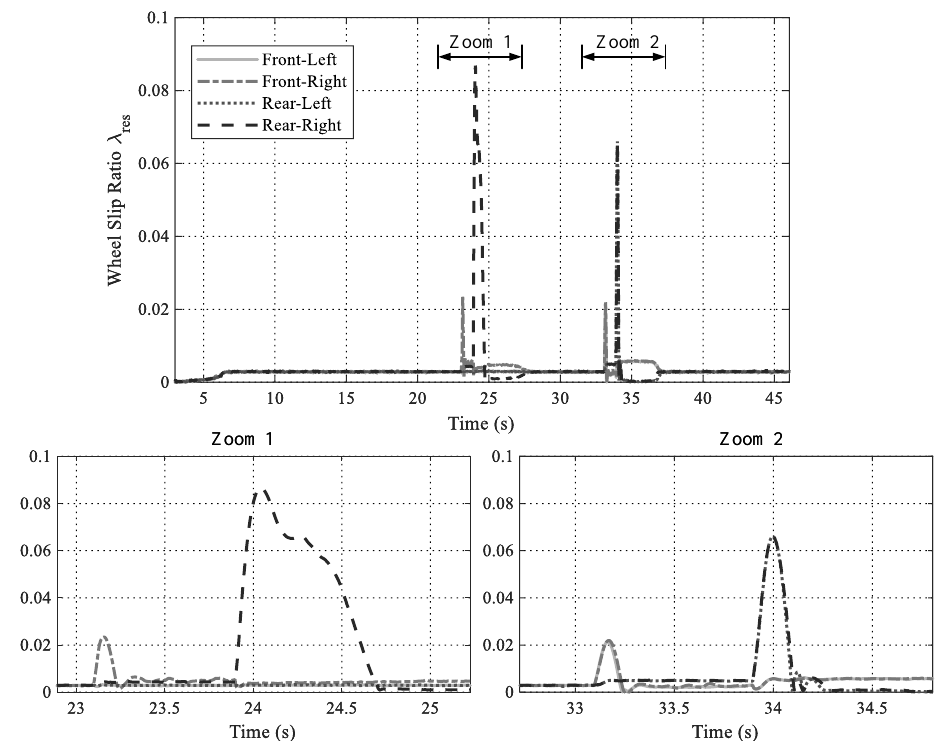
Figure 24. Slip-ratio at each Wheels. The Zoom 1 is associated with Scenario 2 and the Zoom 2 is for Scenario